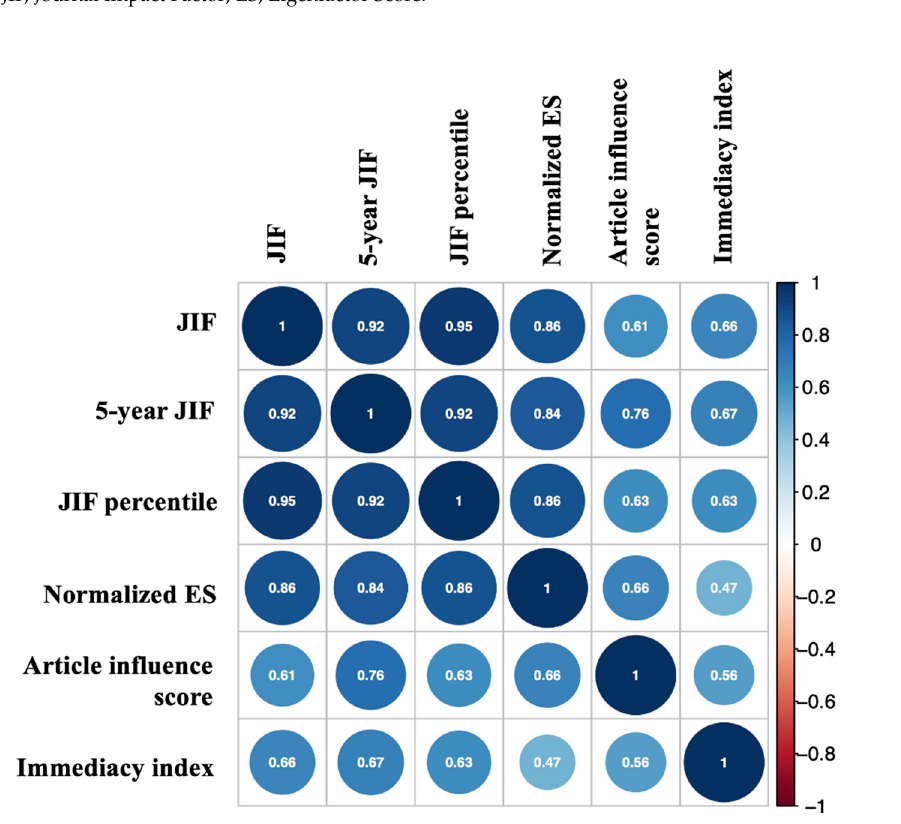
Figure 1. Spearman’s rank correlation coefficient for the included journals. All the correlations